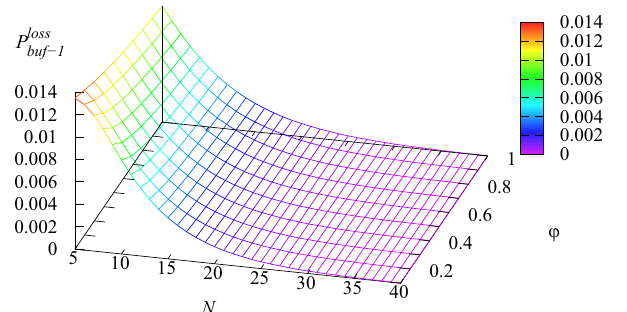
Figure 6. Dependence of the loss probability P loss and N .